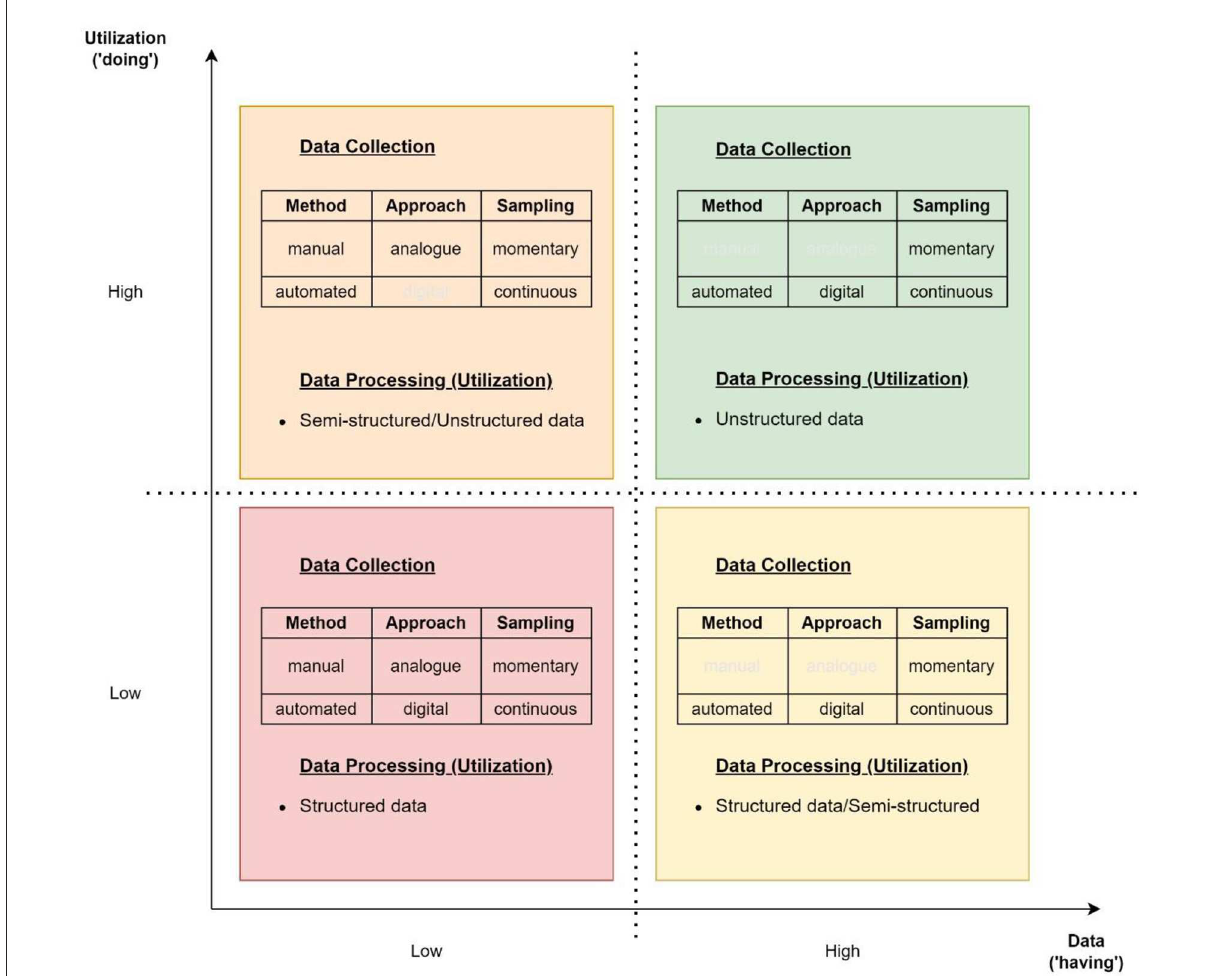
FIGURE3 Mapping data onto the 2 × 2 matrix used later to analyze outcomes in water management, based on the four industrial revolutions—showing how the transition between the digital collection of sample and continuous data and the ability to process unstructured data may be used to define convenient metrics. Grayed out categories are non-applicable fields in the given section of the quadrant descriptive